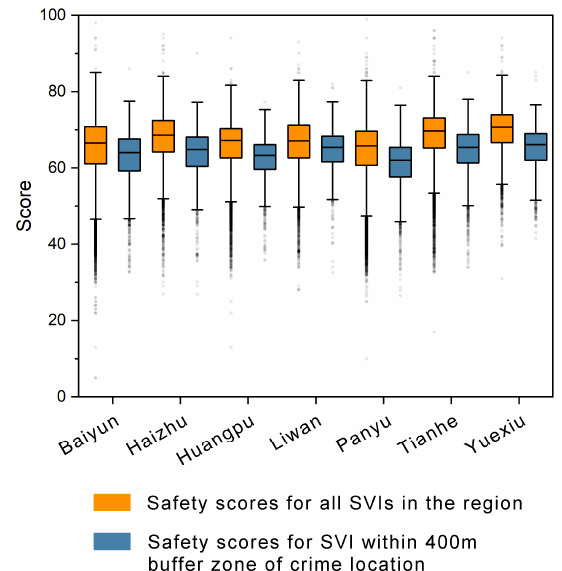
Figure 10. Comparison of safety scores for all city street points and street points within 400 m of the crime location.